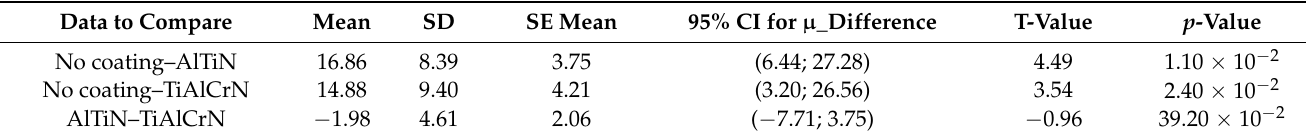
Table 9. Estimation for paired difference and test statistics.